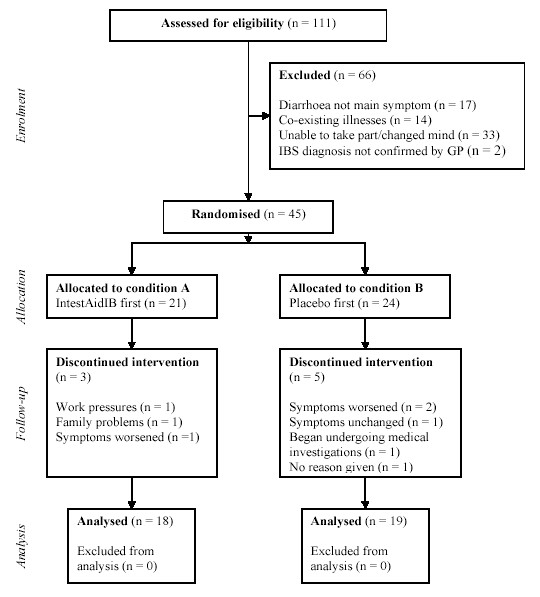
participant flow through the trial.